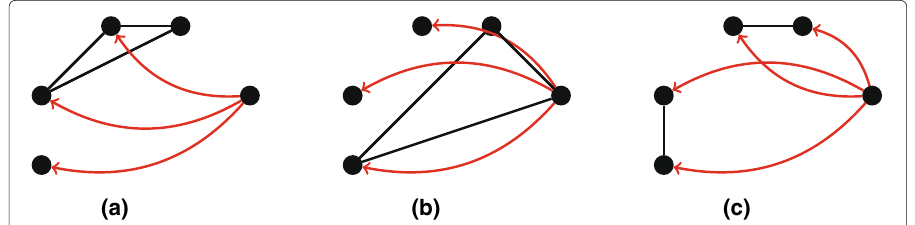
Fig. 8 Highlighted motifs of size 5. Values of r and c denote respectively ratio and concentration cf. “Motif evaluation metrics” section. a Motif of size 5. r = 285266, c = 0.158% b Motif of size 5. r = 2346, c = 0.673% c Motif of size 5. r = 113400, c =